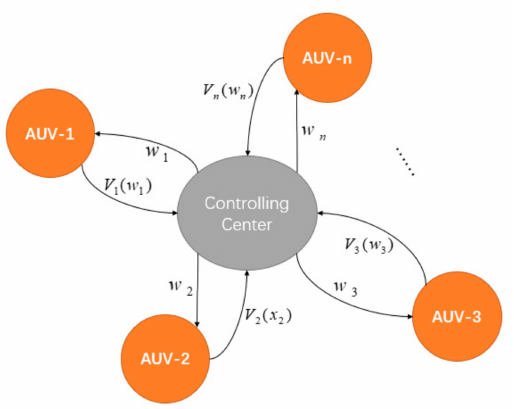
Figure 1. The architecture of the proposed distributed task-allocation